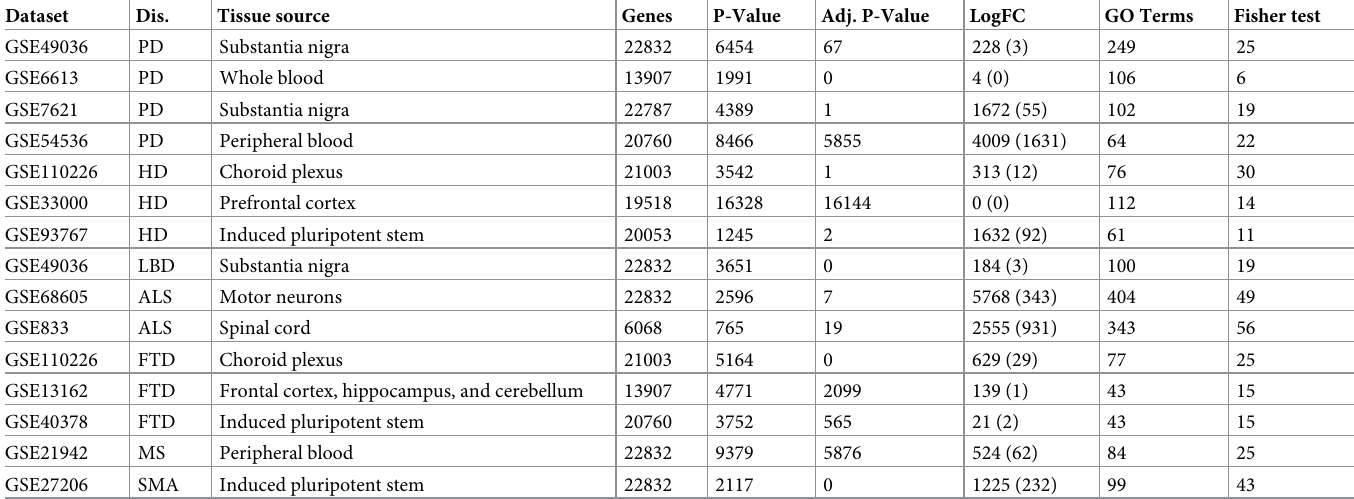
Table 2. Statistical summary for studies of neurodegenerative comorbid diseases of AD. Dataset Dis.